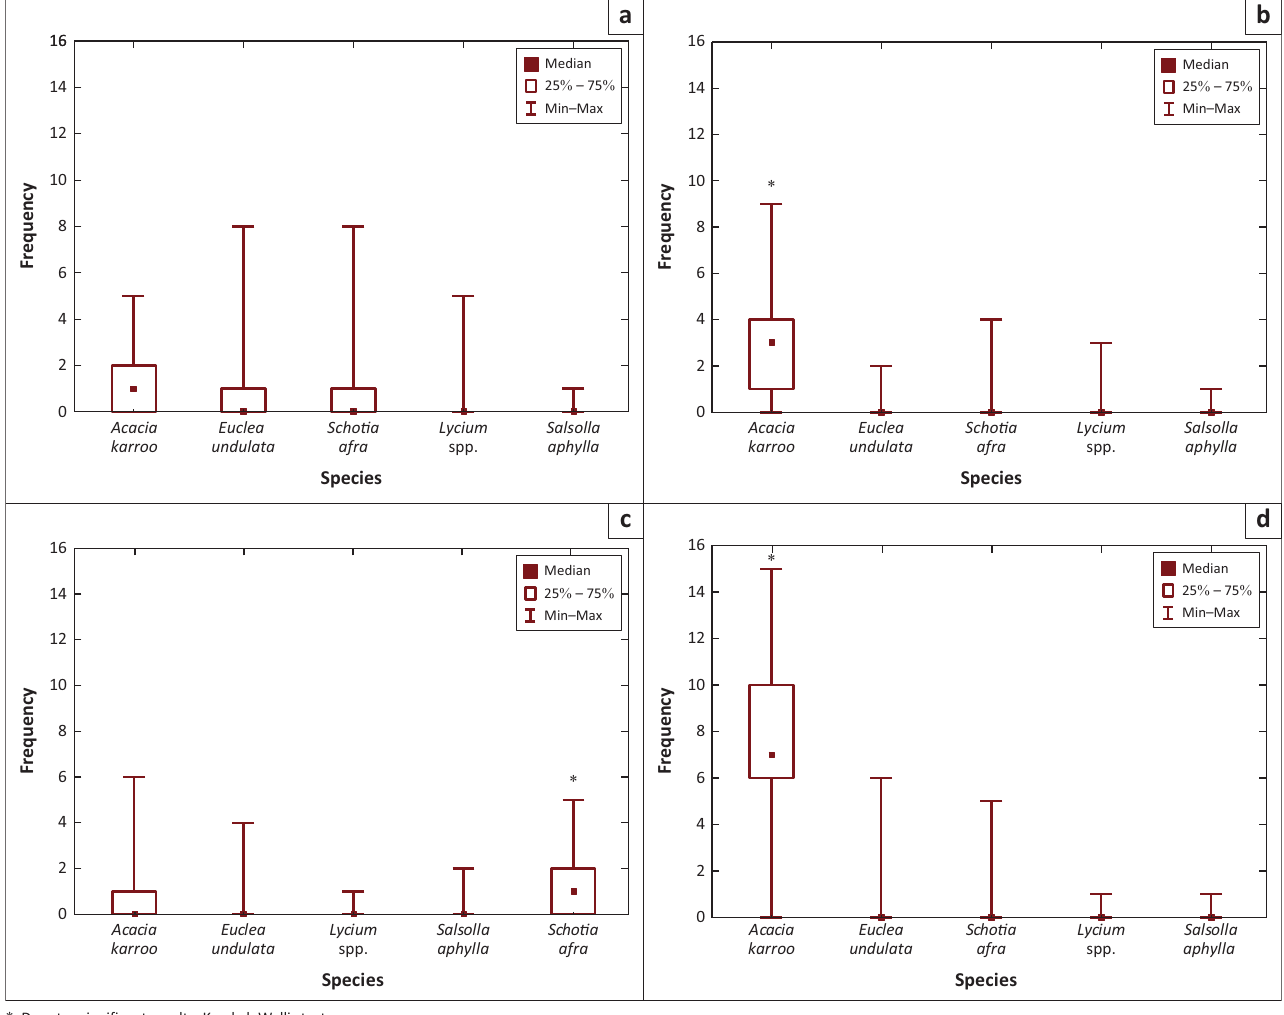
FIGURE 2: Box and whisker plots to show the results of the Kruskal–Wallis tests performed on the direct observation data of giraffe feeding behaviour. (a) The results for summer, where no individual was found to be significantly favoured, (b) the results for autumn, where Acacia karroo was favoured the most, (c) the results for winter, where Schotia afra was found to be the most favoured browse species, (d) the results for spring, where Acacia karroo was by far the most preferentially browsed plant